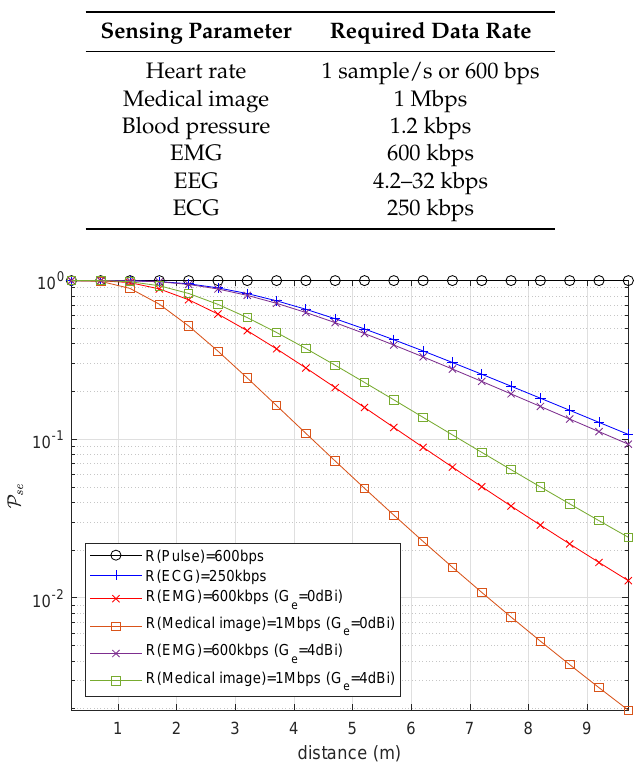
Figure 15. Probability of Successful eavesdropping w.r.t Eve Distance (ISM